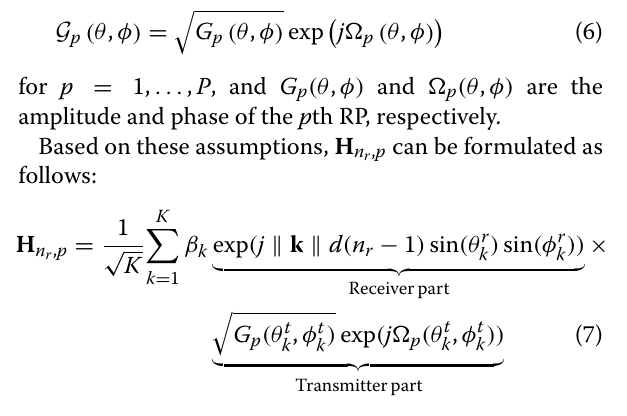
Table 1 Distribution of variables for the considered channel model Variable Distribution PDF β k